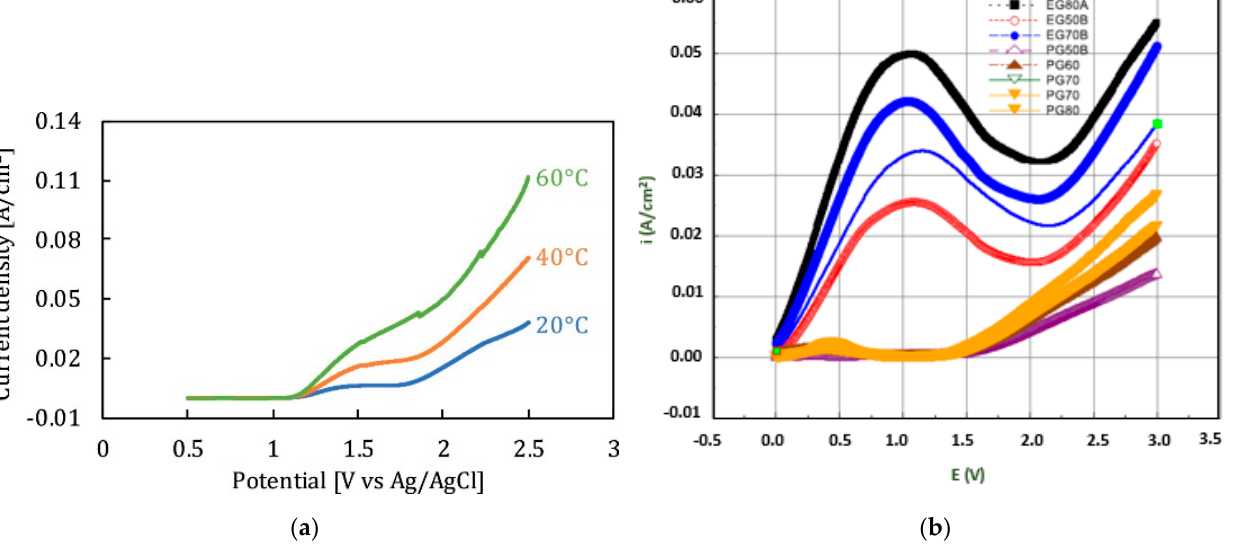
Figure 15. ( a ) The effect of temperature on polarization potential of stainless steel [147], ( b ) Polarization curve for EP of nickel in phosphoric acid and glycerol [151].